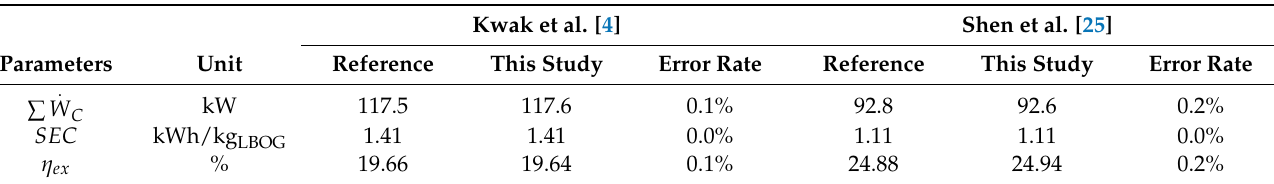
Table 7. Simulation results of previous studies [4,25].